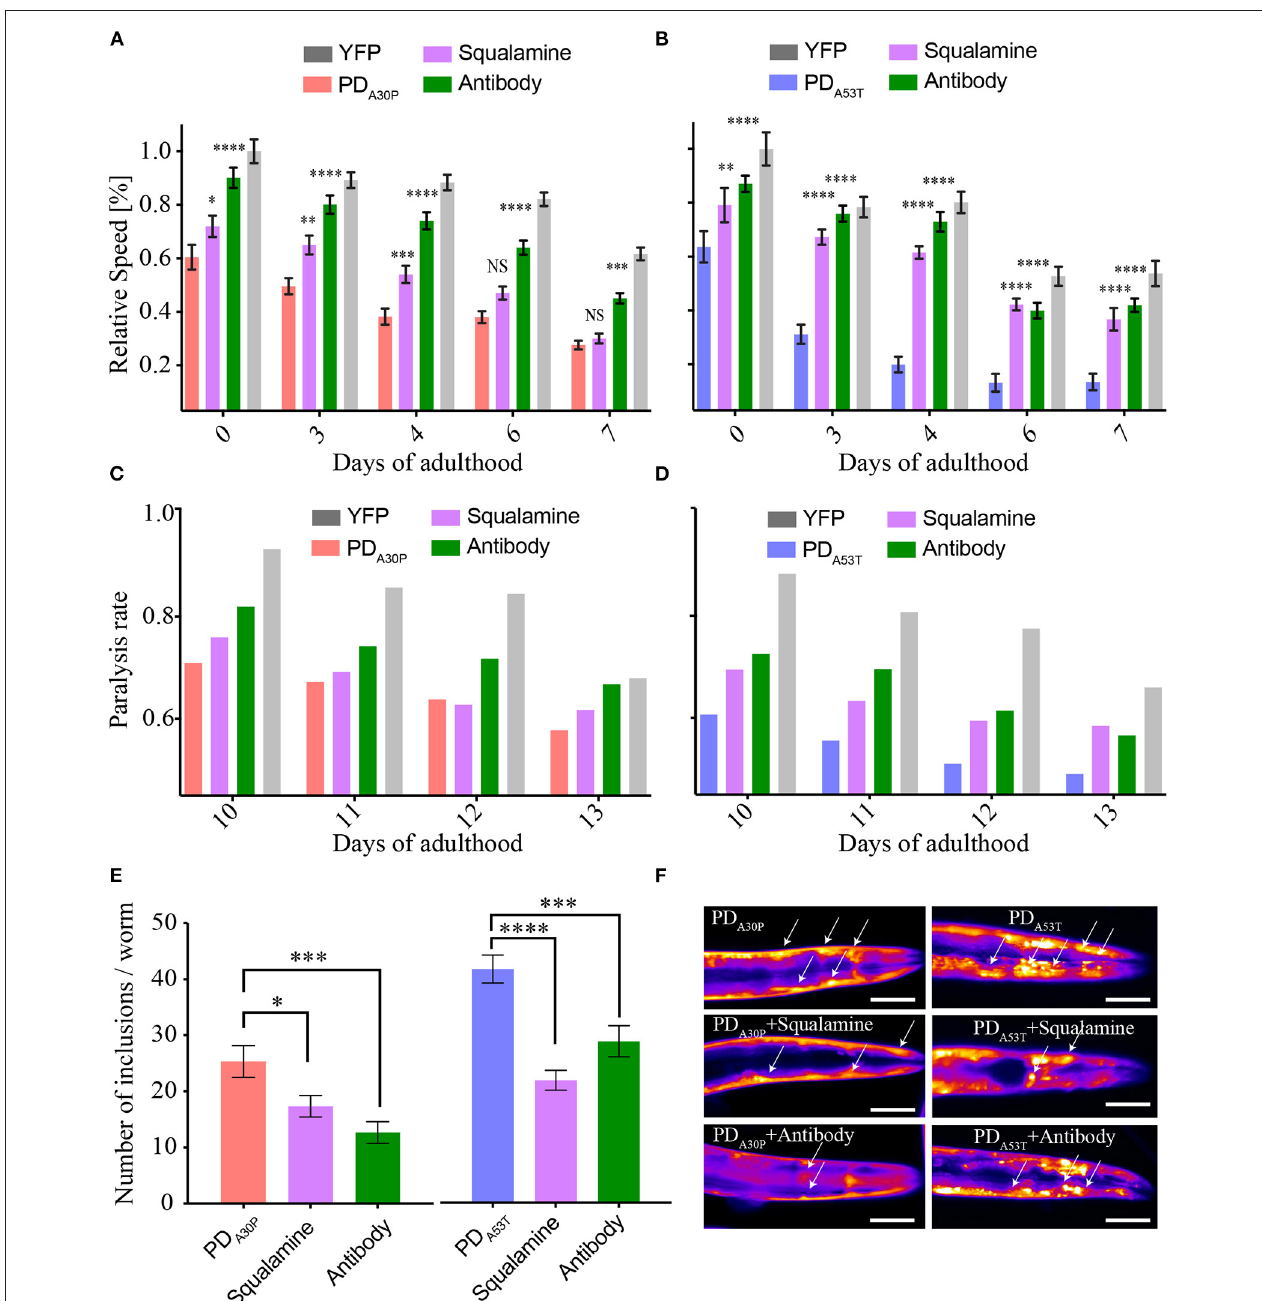
FIGURE 4 | Comparison of the effects of the antibody and squalamine administration to PD A30P and PD A53T worms. (A,B) At a concentration of 10 µ M, the antibody rescues the motility dysfunction (relative speed) induced by the over-expression of A30P, with squalamine having a slightly smaller effect. The worm motility is also rescued in the A53T worms by the antibody and squalamine to similar extents. Errors represent the standard error on the mean (SEM) * P ≤ 0.05, ** P ≤ 0.01, *** P ≤ 0.001 and **** P ≤ 0.0001. (C,D) Paralysis rate, reported as the fraction of worms that are mobile, corresponding to the time points shown in (A,B) ; the variability between biological replicates is in the 2–9% range, and the variability between technical replicates is in the 1–4% range. (E,F) Number of inclusions at day 12 of adulthood * P ≤ 0.05,*** P ≤ 0.001 and **** P ≤ 0.0001. The scale bar indicates 80 µ